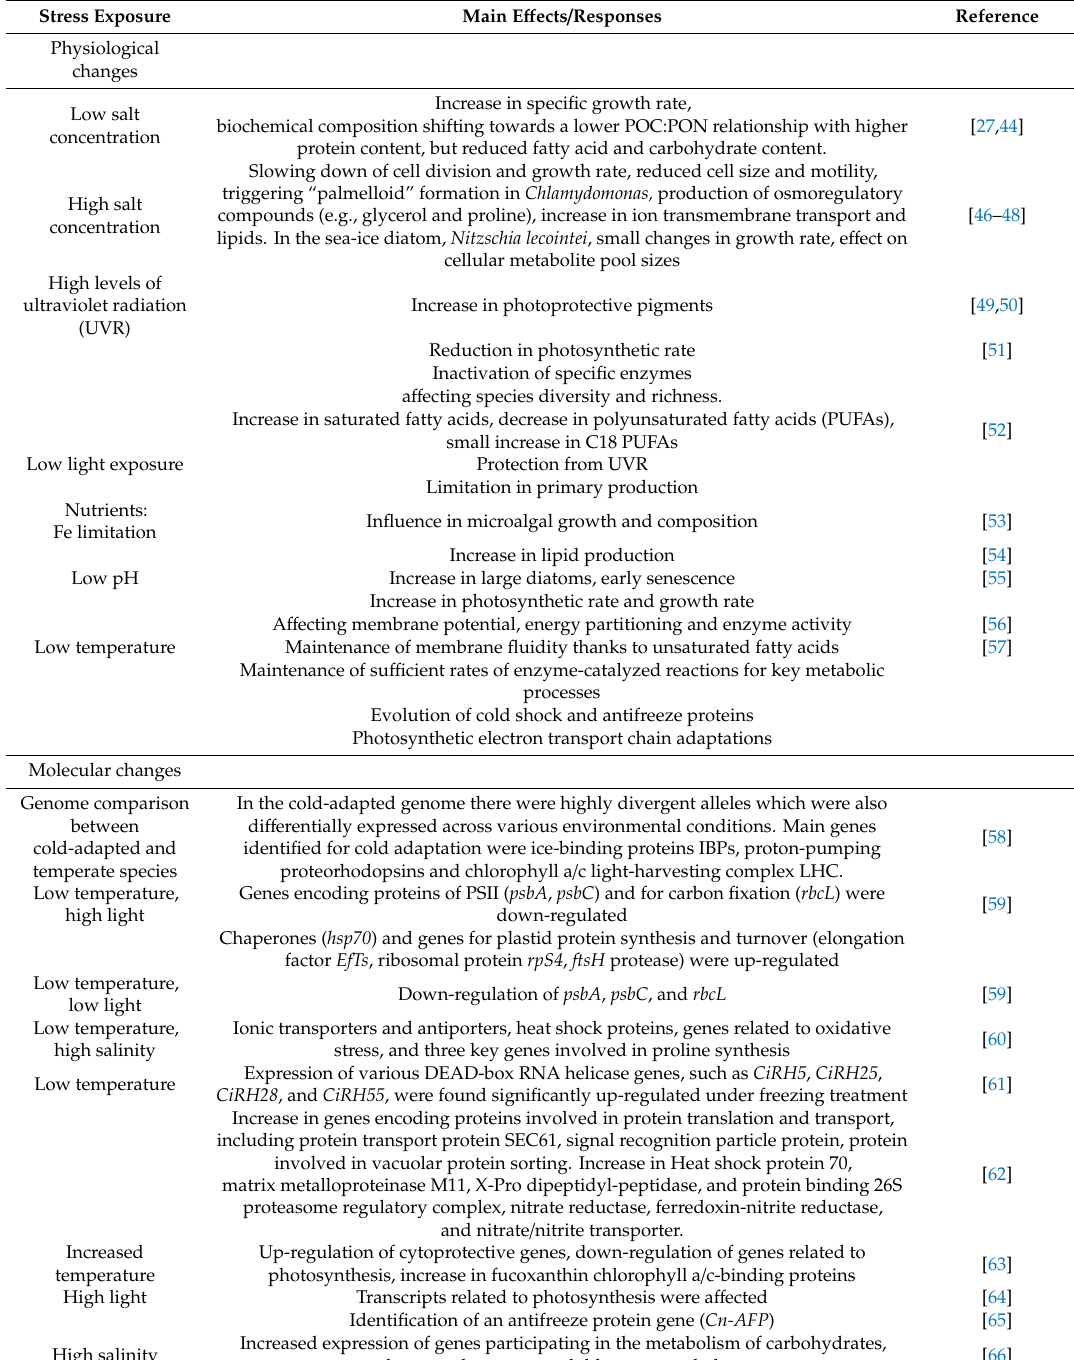
Table 1. Main physiological and molecular e ff ects / responses observed for microalgae exposed to stressful conditions encountered in polar